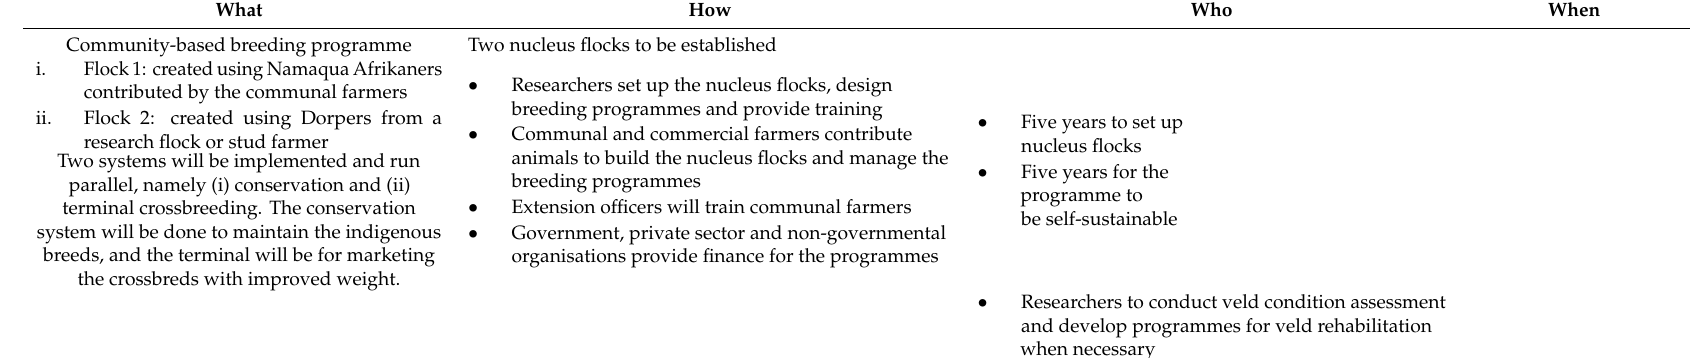
Table 2. Sustainable utilisation plan to